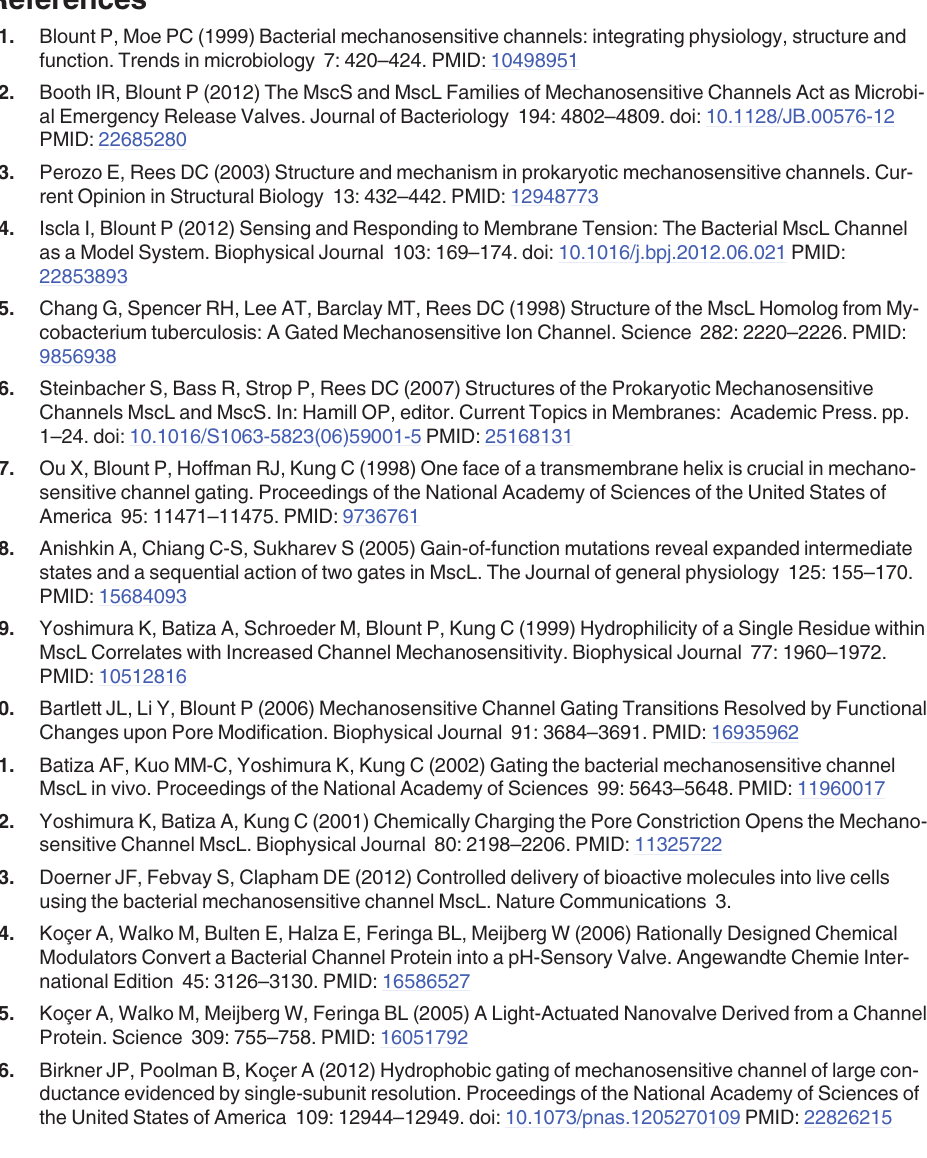
S1 Table. Backbone RMSD (in Ang) of the engineered MscL channels.